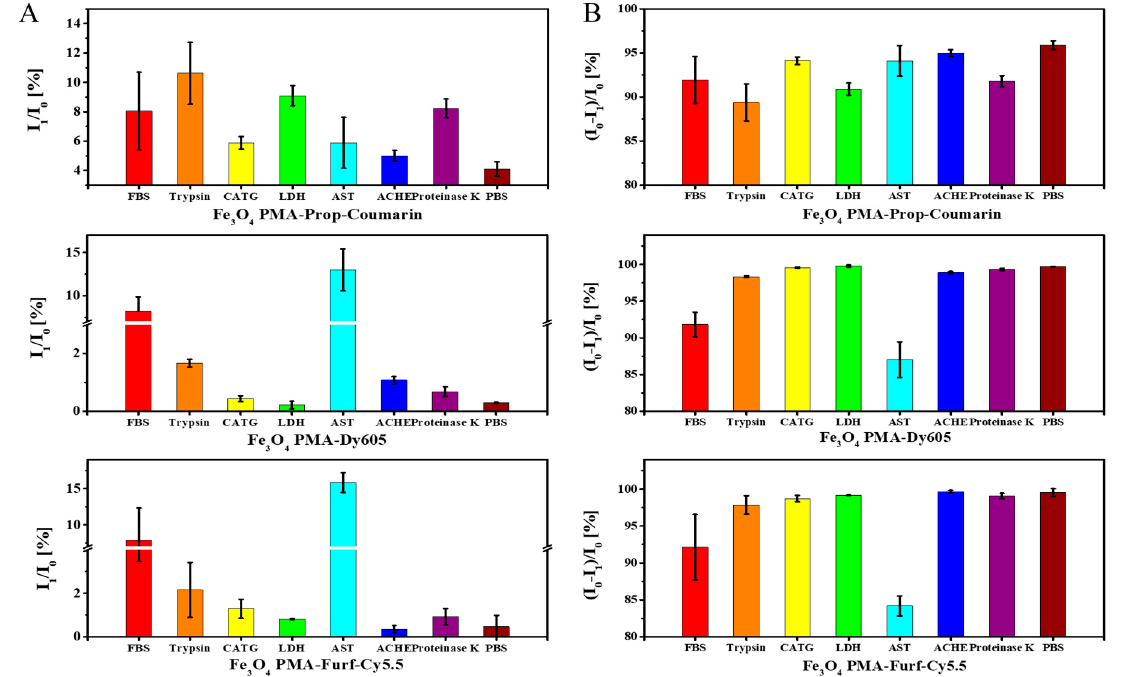
Figure 4. ( A ) I 1 /I 0 and ( B ) (I 0 -I 1 )/I 0 of Fe 3 O 4 PMA-Prop-Coumarin NPs, Fe 3 O 4 PMA-Dy605 NPs, and Fe 3 O 4 PMA-Furf-Cy5.5 NPs.